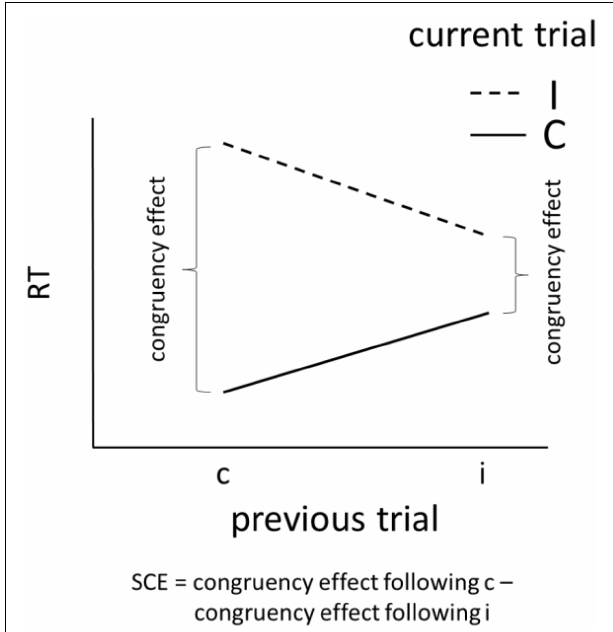
FIGURE 1 | The sequential congruency effect (SCE), a.k.a. conflict